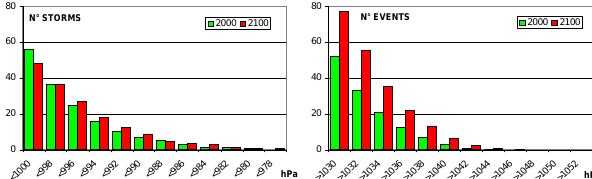
Figure 5. C umulated distributions of MSLP events below fixed thresholds (left panel) and high MSLP events above fixed thresholds (right panel) at the ISMAR-CNR platform.